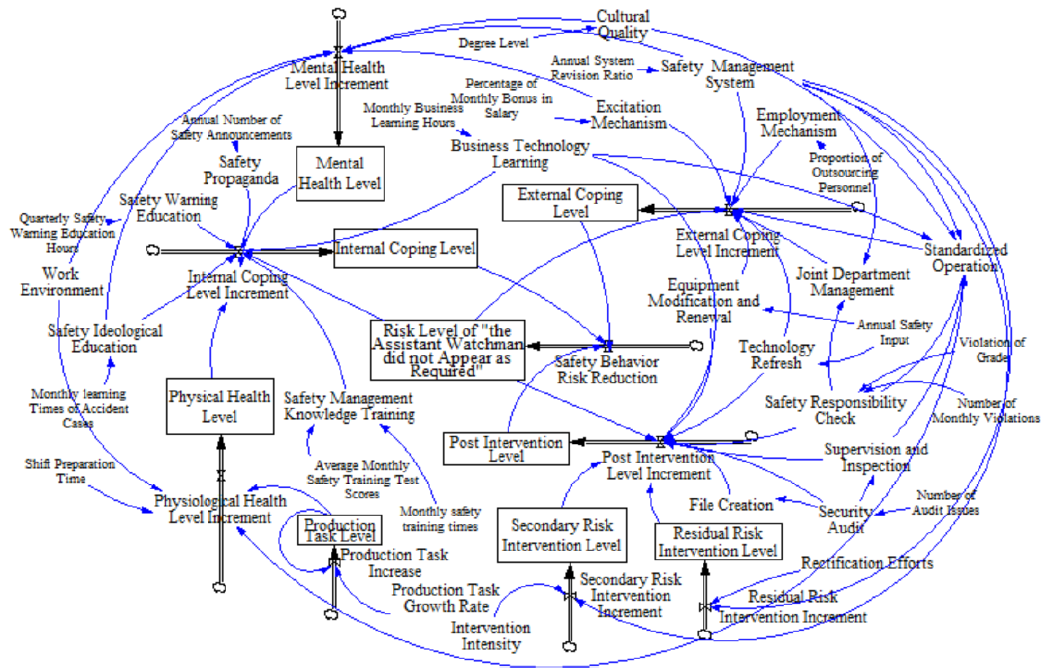
G . Figure 12. Dynamics flow diagram of grid G H